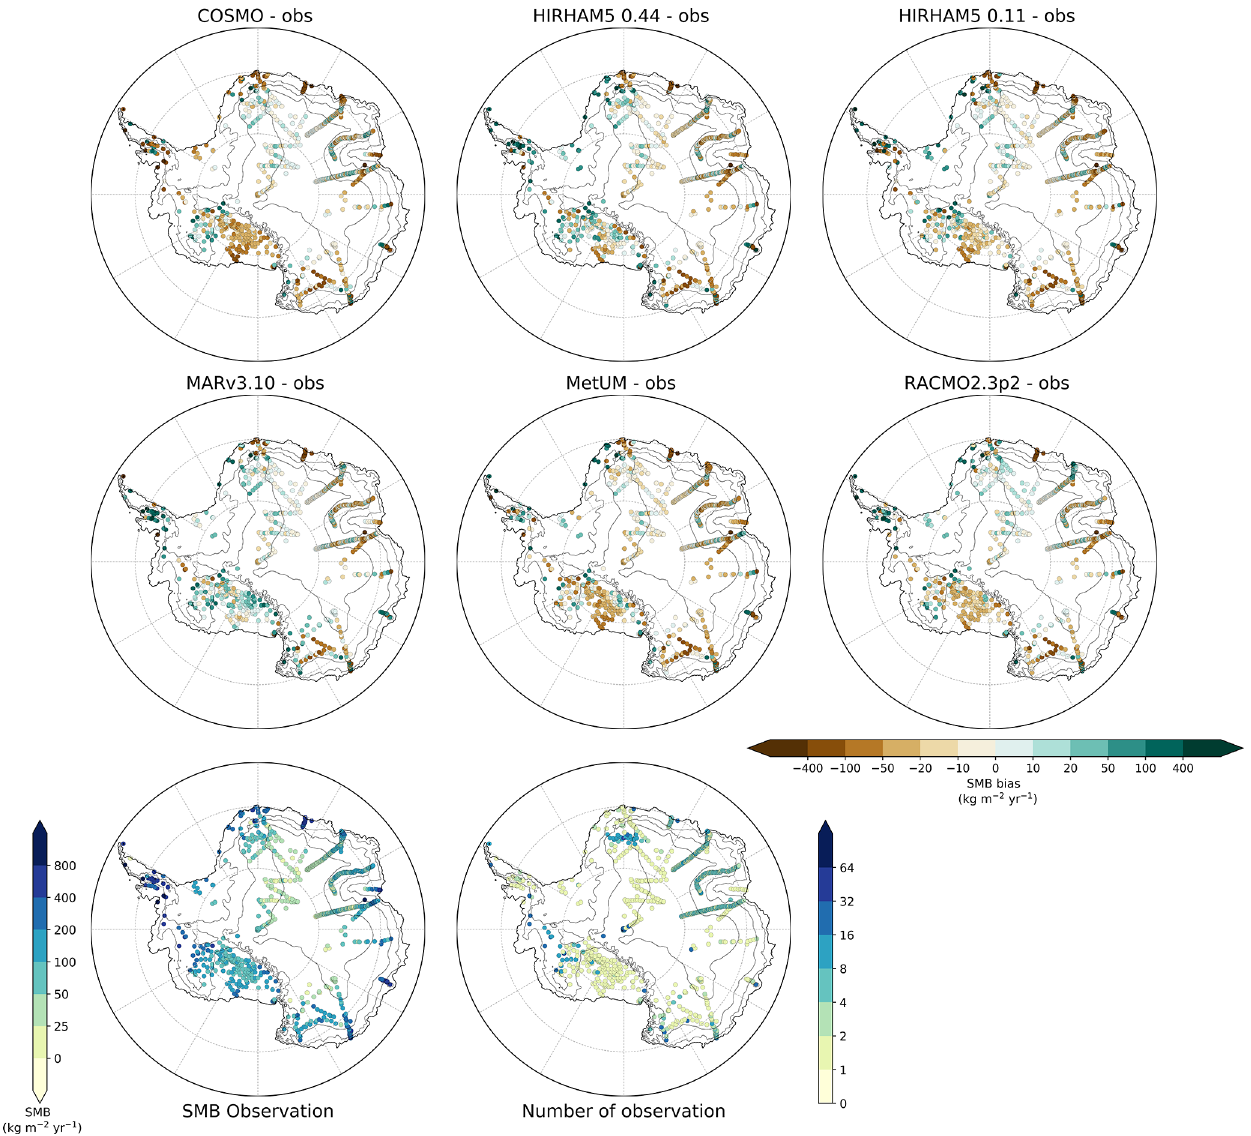
Figure 4. Observed SMB values and the number of observations at each point. The model plots show the difference between observed and modelled SMB for COSMO-CLM 2 , HIRHAM5 0.44 ◦ , HIRHAM5 0.11 ◦ , MAR v3.10 , MetUM, and RACMO2.3p2.